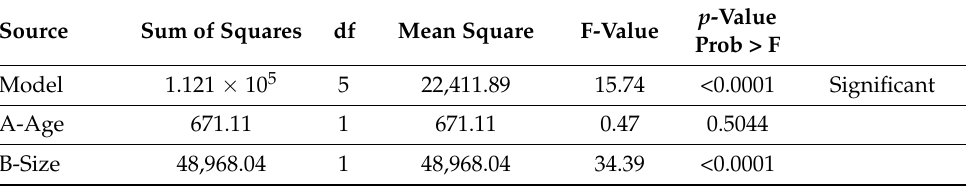
Table 2. Analysis of variance (ANOVA) and determination coefficients for the quadratic nonlinear model for fresh cell growth [Partial sum of squares—Type